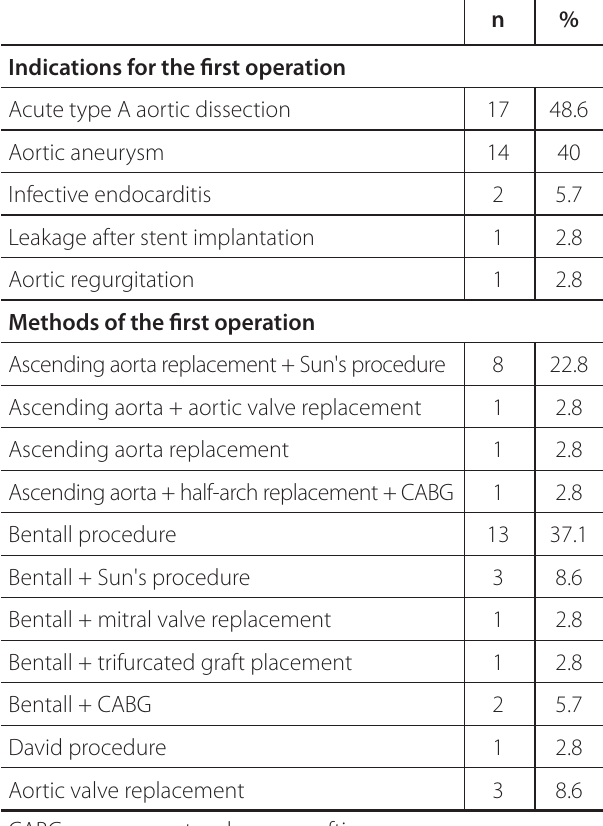
Table 2 . Indications and methods of the first aortic operation.